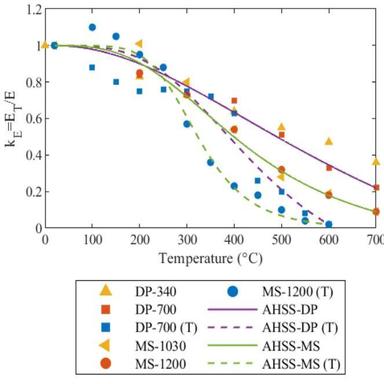
Comparison of proposed retention factors for elastic modulus with test data.